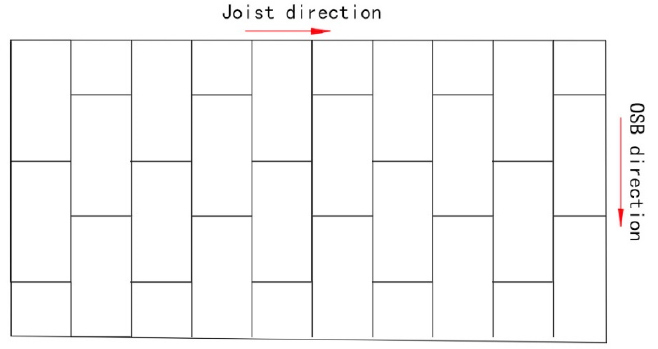
Figure 3. Connection between the floor and the wall.